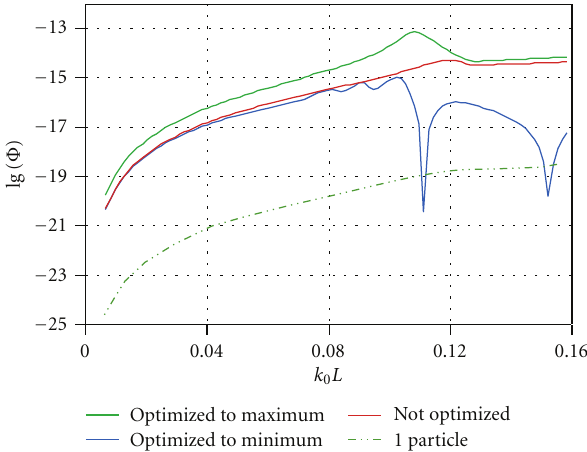
Figure 3: The logarithm of the reflectance Φ of the optimized Au cluster versus the normalized frequency k 0 L . The reflectance was optimized for the frequency k 0 L = 0 . 11 at the observation point r ob = { 0 . 87,0 . 5,0 . 00 } . The period of the cluster is d = 5 L and L = 10nm. The green and the blue curves show the reflectance of the cluster optimized for maximal and minimal values, respectively. The red curve shows the reflectance of the nonoptimized cluster, and the green dash-dotted curve shows the reflectance of the single Au cube with the characteristic size L